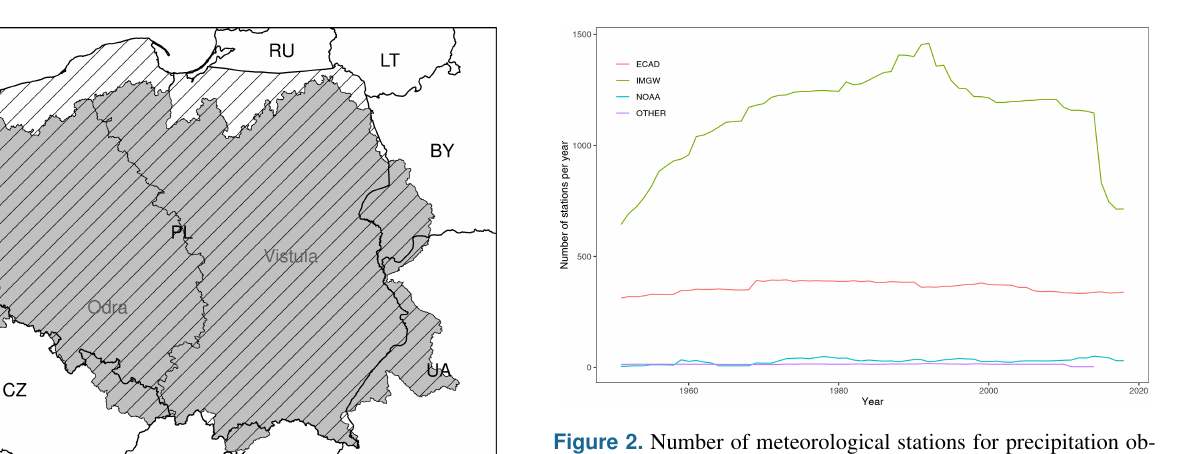
Figure 2. Number of meteorological stations for precipitation ob- servations per year from 1951 to 2019.